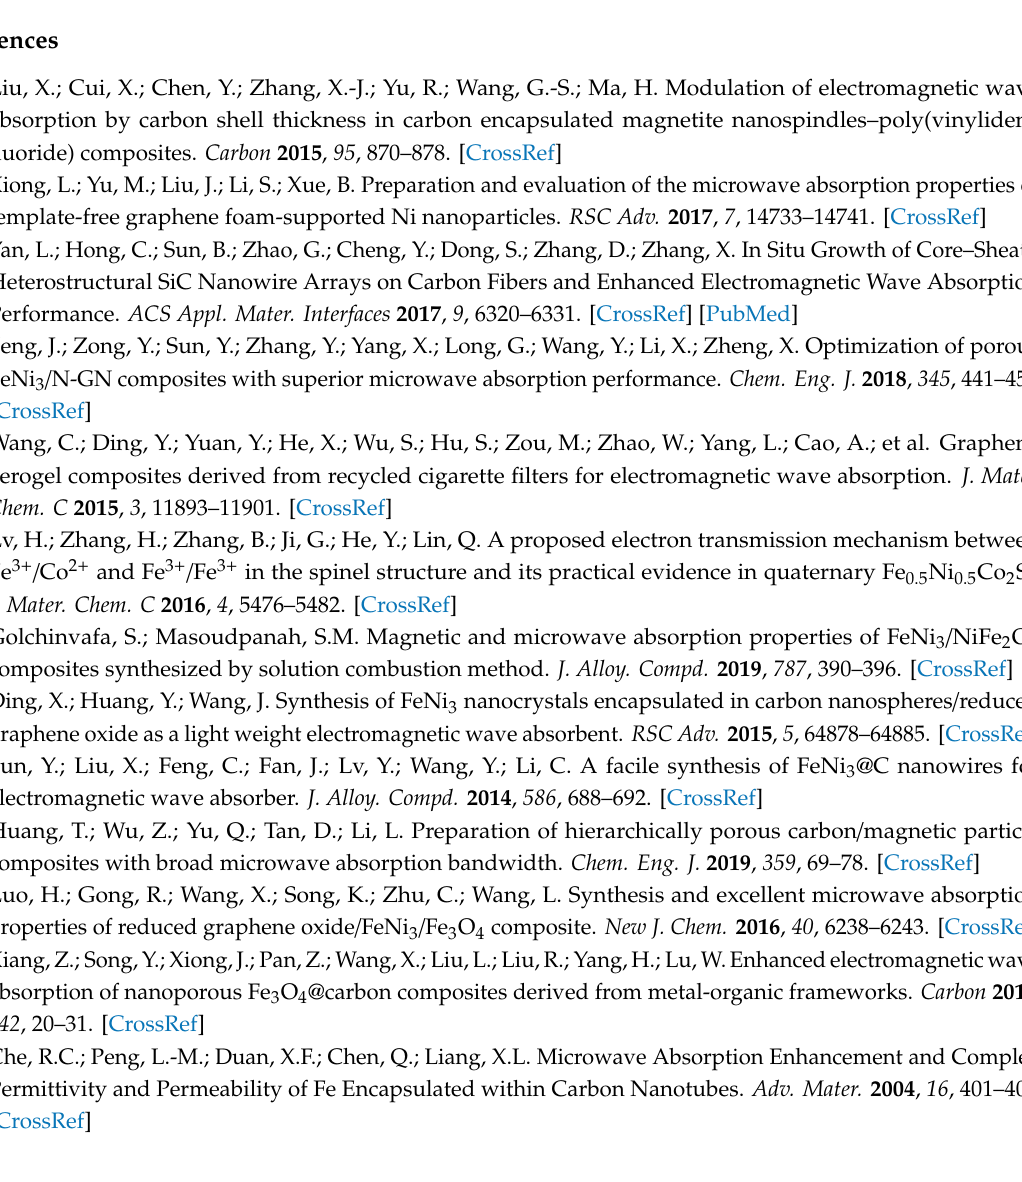
Figure S1: SEM images of (a,b) S1, (c,d) S3. Figure S2: (a) Real parts of complex permittivity and (d) permeability, (b) imaginary parts of complex permittivity and (e) permeability, (c) dielectric and (f) magnetic loss tangents of S2 with the filler loadings of 10, 20, 30, and 40 wt%, respectively. Figure S3: The RL values of the S1–S3 with a thickness of 3.0